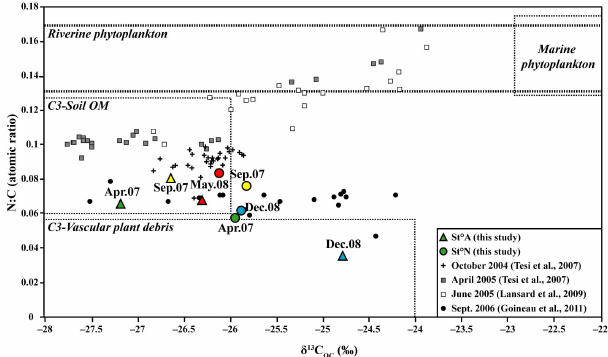
Fig. 10. Stable isotopic composition of the organic carbon ( δ 13 C OM ) vs. N:C atomic ratio for the first half-centimetre of sedi- ment measured at Stations A and N during the four sampling peri- ods. The four other databases represented were collected in Septem- ber 2006 (Goineau et al., 2011), October 2004 and April 2005 (Tesi et al., 2007), and June 2005 (Lansard et al., 2009). The composi- tion of four possible OC sources (C 3 -vascular plant detritus, C 3 -soil OM, marine and riverine phytoplankton detritus) is also plotted to illustrate the relative influence of each source. The N:C ratio was used rather than the classical C:N ratio because the former are more robust statistically and behave linearly in a mixing model (Gordon and Go˜ni,